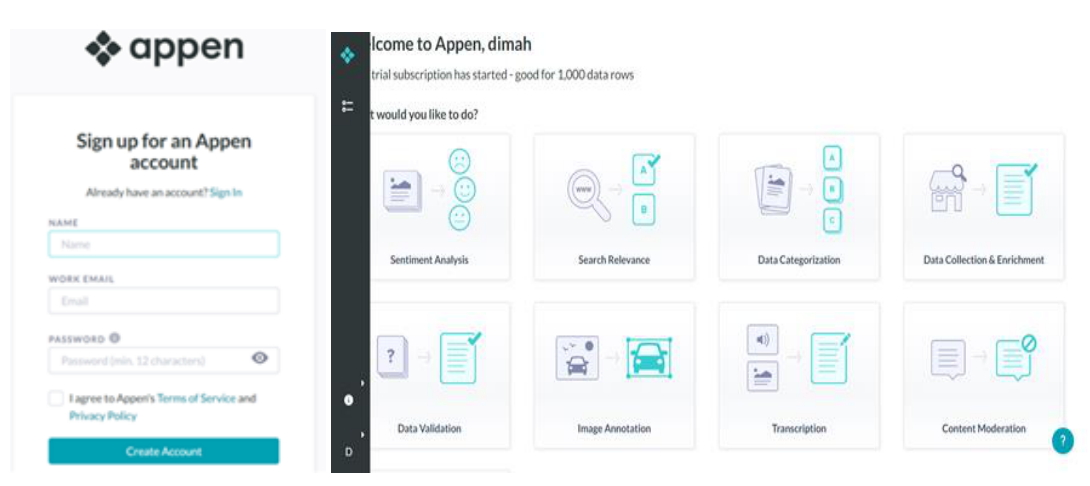
Figure 12. Client account and project in Appen.